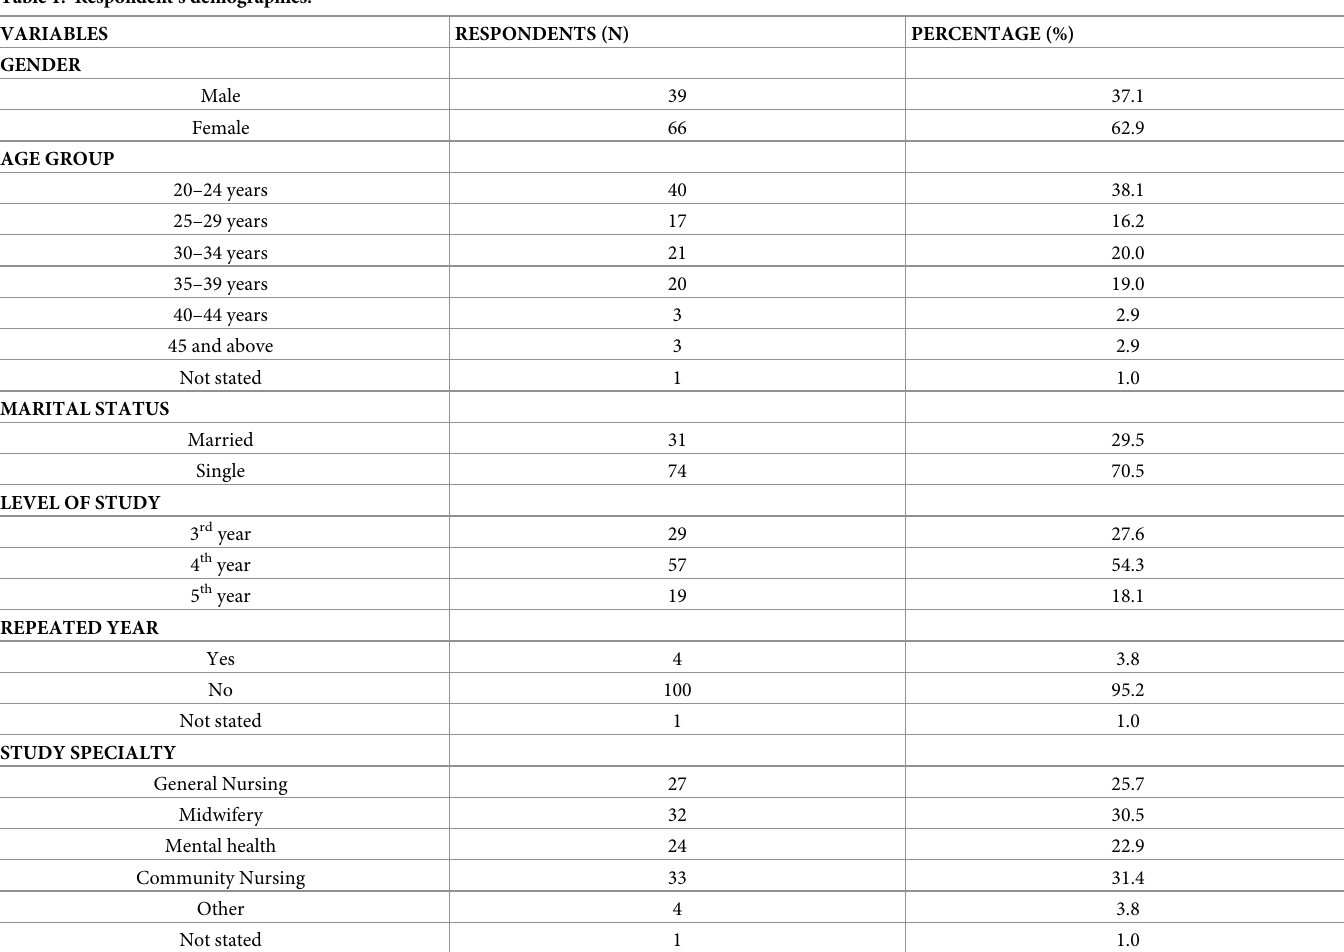
Table 1. Respondent’s